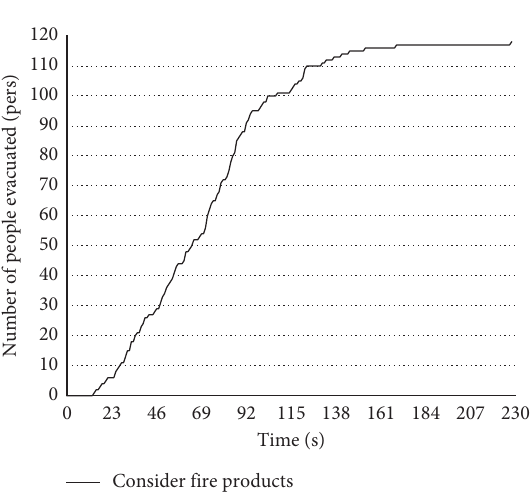
Figure 34: Exit 8 evacuation